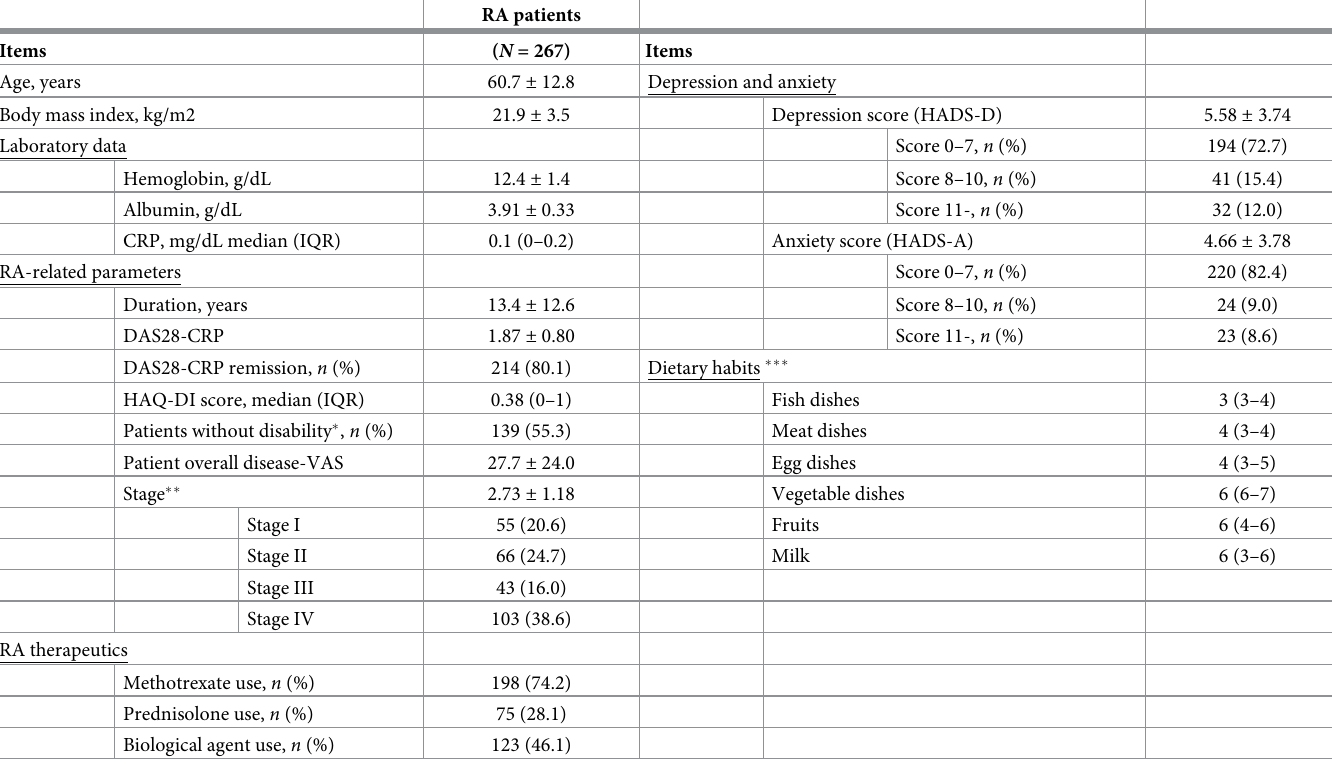
Table 1. Baseline characteristics of study